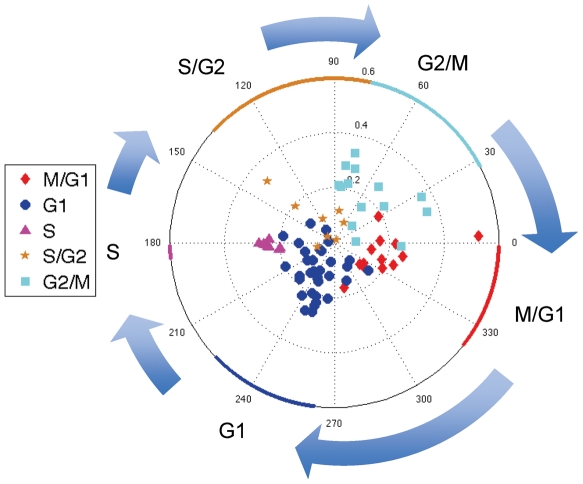
POPs in polar coordinates for experimentally identified ‘cell cycle’ genes.These genes are previously by experimental methods classified into five clusters based on the timing of their maximal expression in different phases of the cell cycle: G1(round), S(triangle), S/G2(star), G2/M(square) and M/G1(diamond). The median POP phases of the five experimentally defined clusters are 331.4° (S/G2), 266.6° (G2/M), 182.4° (M/G1), 102.0° (G1), and 32.4° (S). Genes classified as maximally expressed in the same cell cycle phase have similar POP phases. Different POP phases correspond to different phases of the cell cycle.